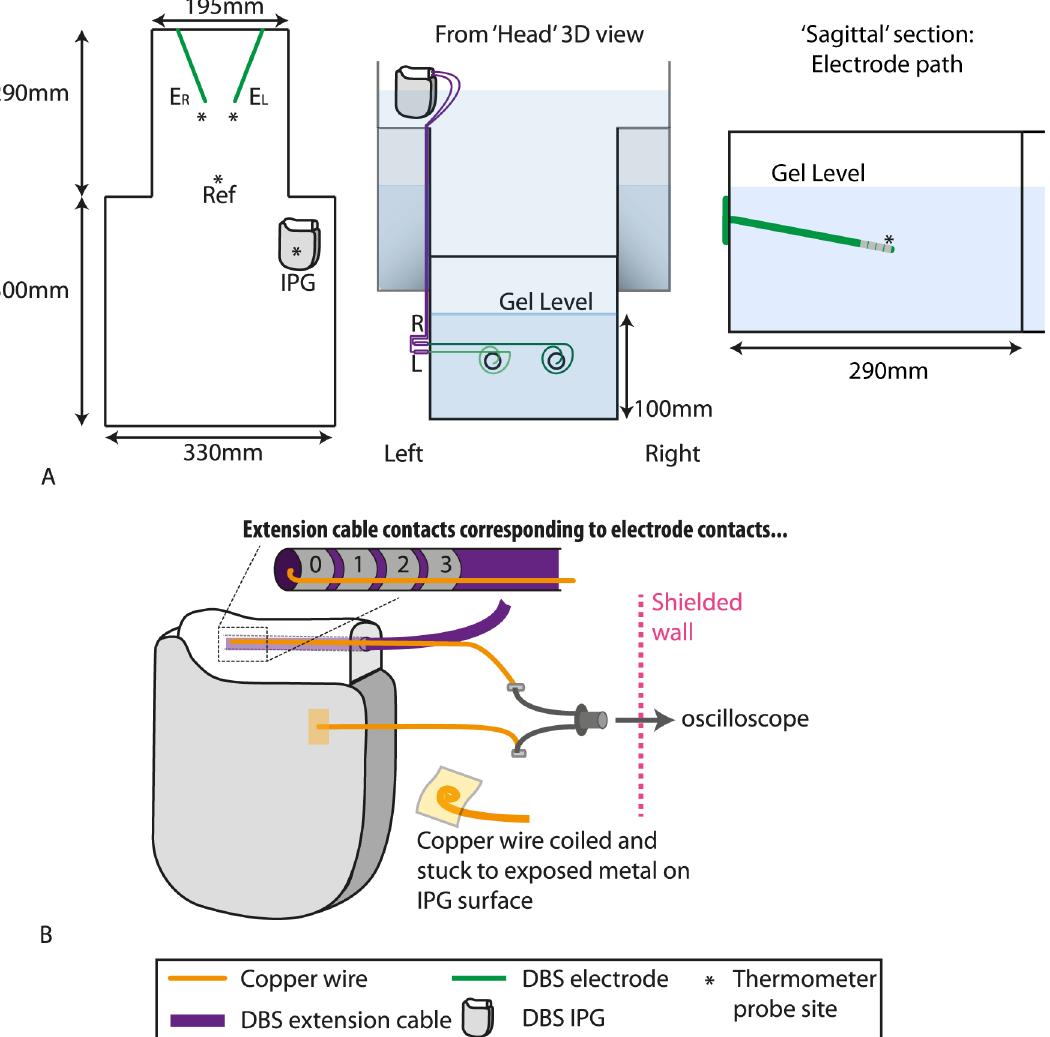
Fig 2. In vitro model of DBS patient implanted at this centre. Note that the extension cables are routed along the external surface of the phantom. (A) Phantom dimensions. * = thermometer recording site, IPG = Implantable pulse generator. (B) Recording the voltage output of the IPG. EL = left electrode, ER = right